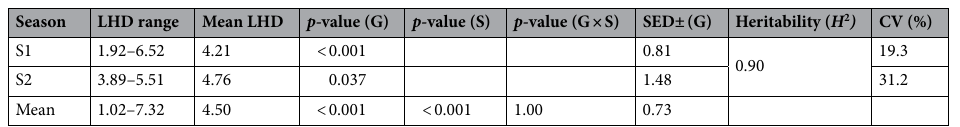
Table 1. Variance analysis (ANOVA) of leaf hair density (LHD) measured in 293 Aegilops tauschii accessions grown in a growth chamber in two seasons (S1: 2018–2019 and S2: 2019–2020). SED ± : standard error of differences; CV: coefficient of